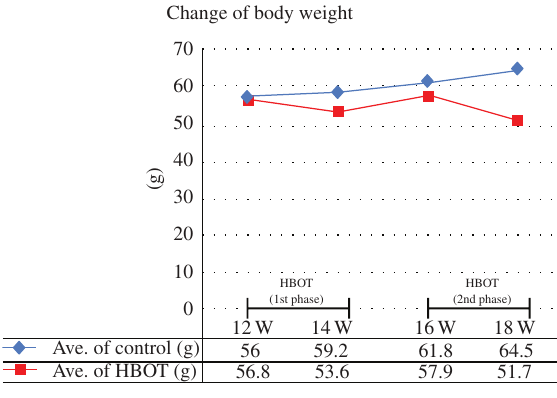
FIGURE 1: Change in body weight.